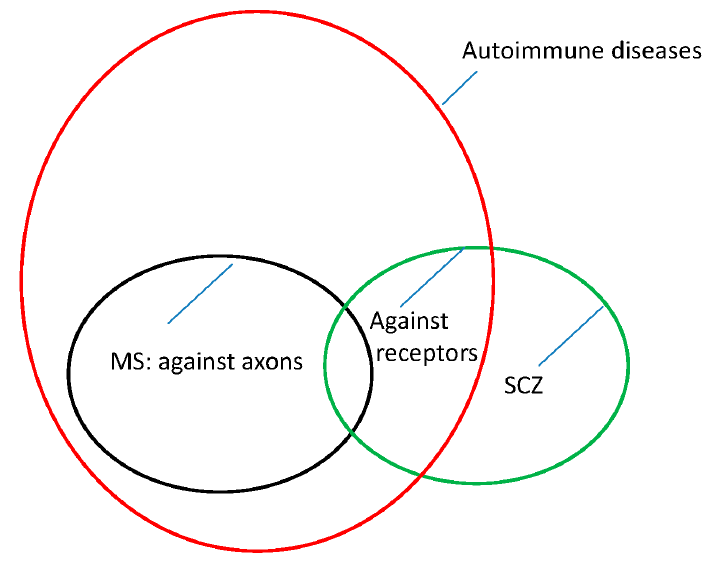
Figure 1. A theoretical picture of the situation: All MS and a subgroup of SCZ cases are thought to be caused by an autoimmune caused by an autoimmune process.